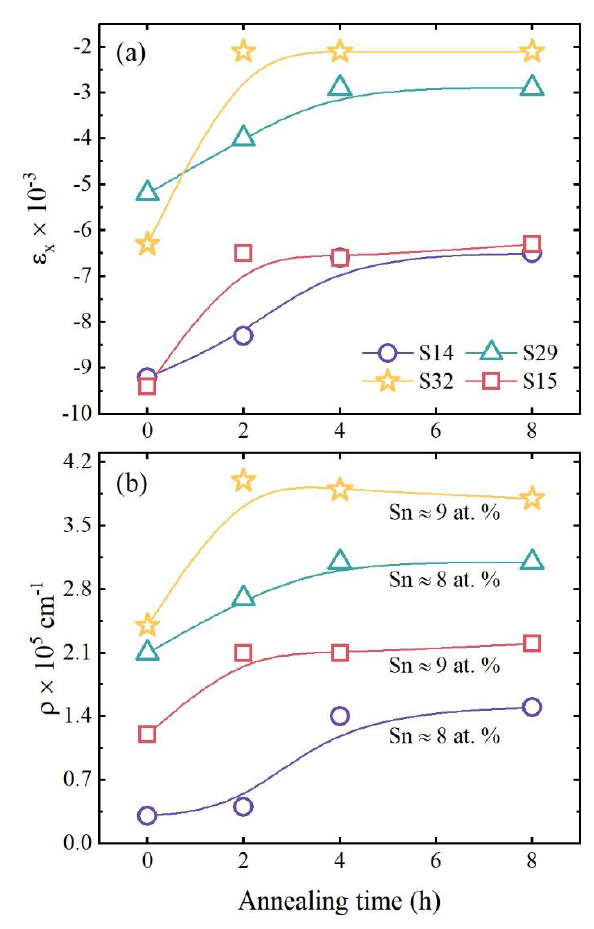
Figure 3. The strain ( a ) and density of misfit dislocations ( b ) as a function of annealing for samples S14, S15, S29, and S32.